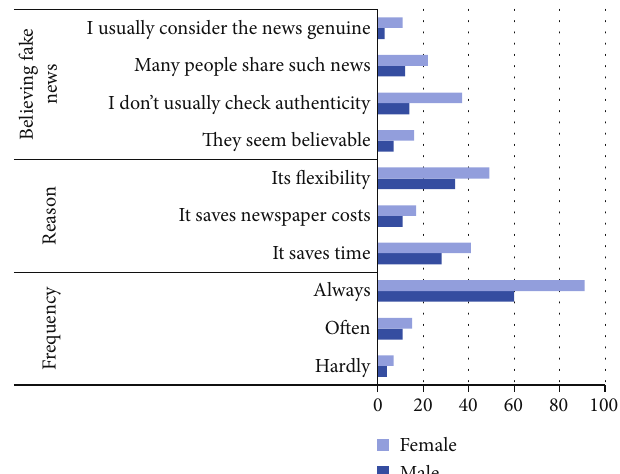
Figure 6: News on social media.